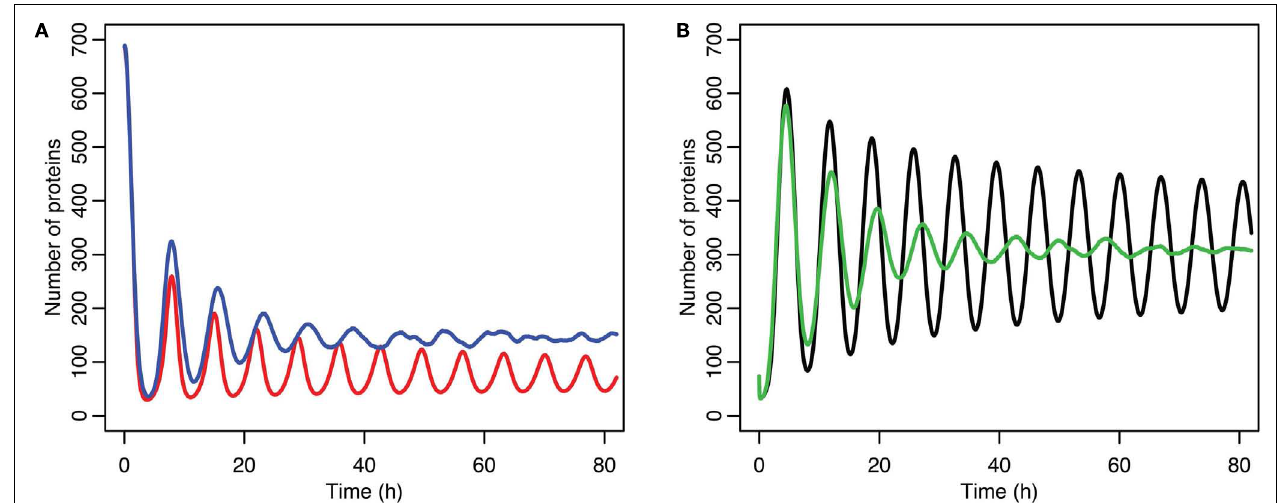
from the mean of 5,000 runs of the stochastic model in blue. (B) Shows the comparison for p53 with the deterministic model in black and from the mean of 5,000 runs of the stochastic model in green.